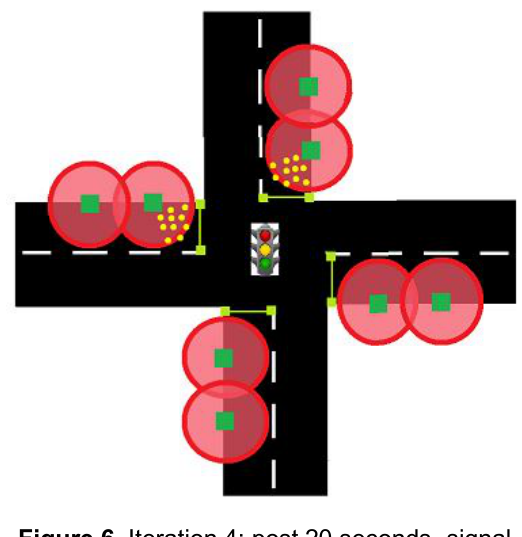
Figure 6. Iteration 4: post 20 seconds -signal on the south lane has been opened